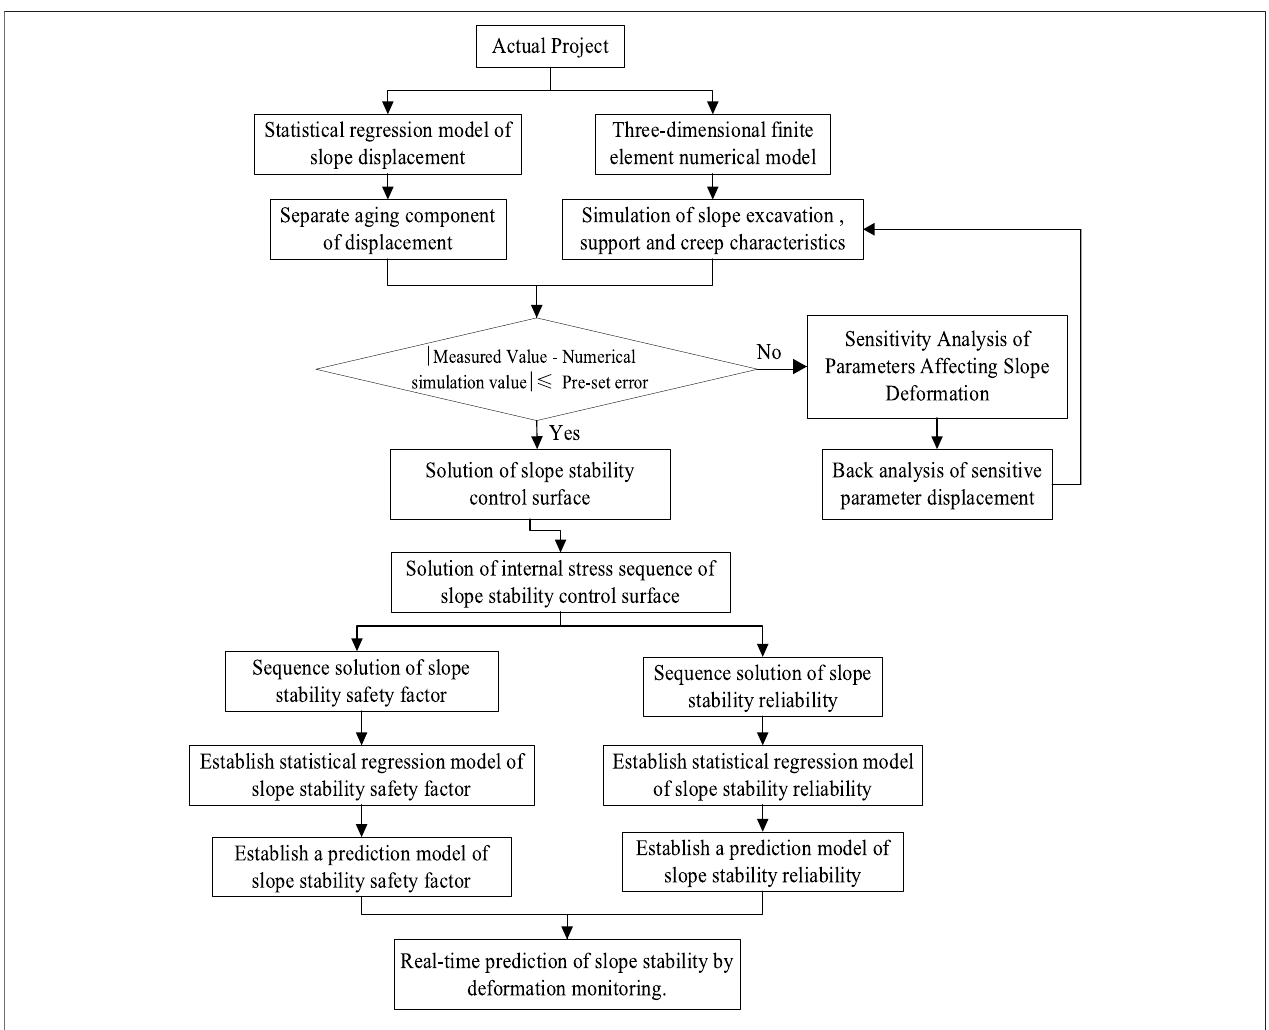
FIGURE 2 | Flow chart of rock slope stability, safety, and reliability prediction method based on deformation monitoring.